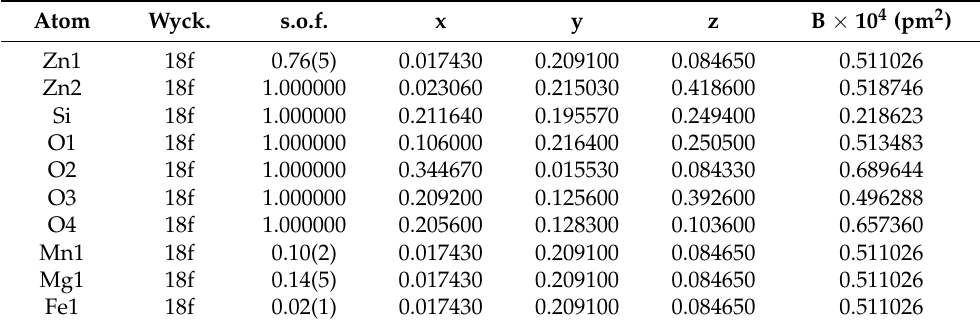
Table 4. Refined structural parameters for W1 sample Zn 1.74 Mg 0.13 Mn 0.10 Fe 0.01 ) ∑ 1.98 Si 1.01 O 4 ob- tained from the Rietveld refinement using X-ray powder diffraction data at room temperature. Atom Wyck.